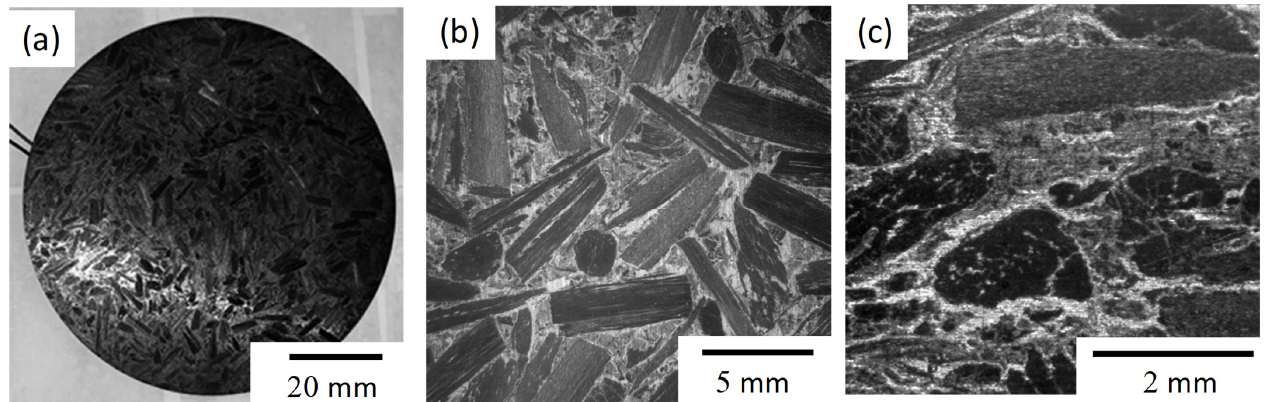
Figure 4. A typical example of (C/C)Si/SiC composite: ( a ) the overview of the specimen, ( b ) parallel, and ( c ) perpendicular to through-thick-direction. Table 2. Mechanical properties of composite material that specimens were made from.